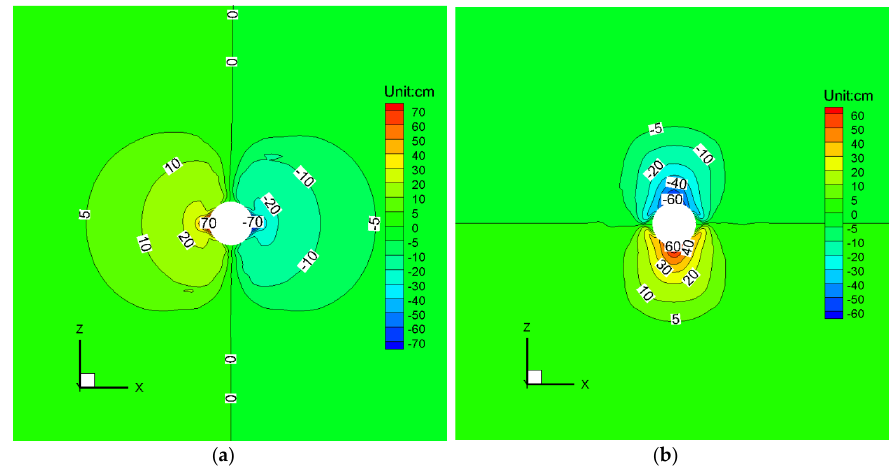
Figure 18. The surrounding rock mass’s displacement without the support scheme: ( a ) Horizontal displacement., ( b ) Vertical displacement.